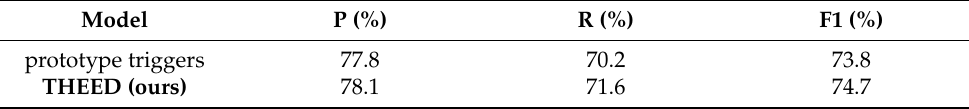
Table 7. Performance of the framework replacing hierarchy concept with prototype triggers. Model prototype triggers